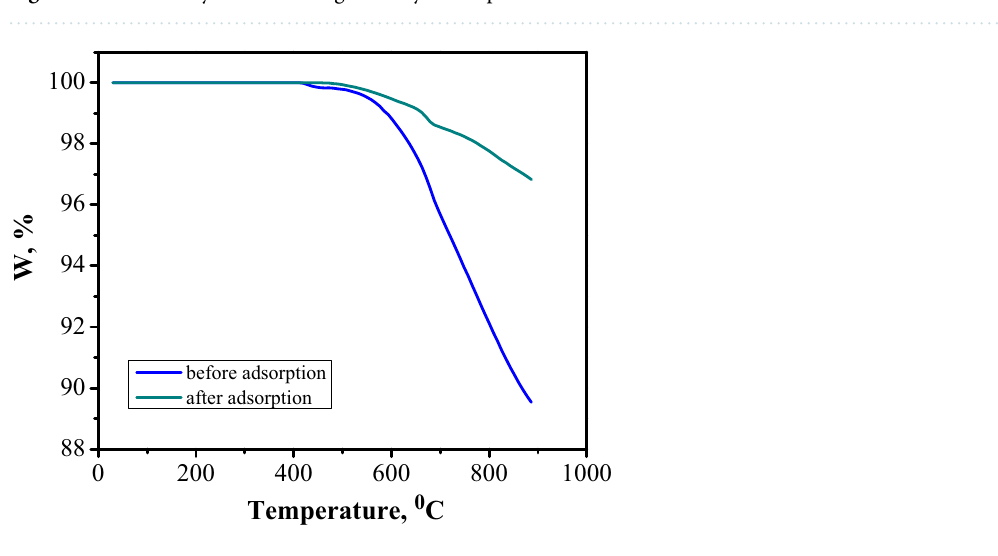
Figure 20. Comparison of TGA